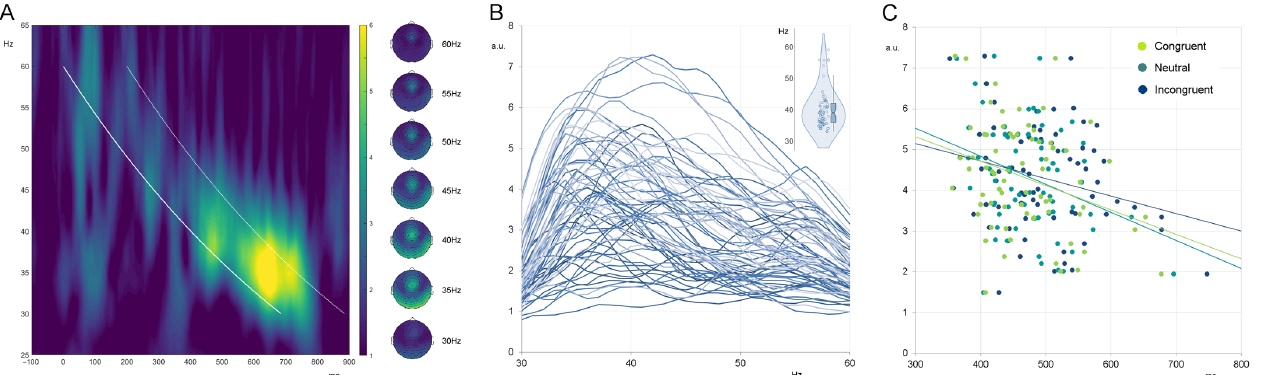
Figure 2. ( A ) The grand averaged time–frequency plot of the phase-locking index alongside the topographic activation plots at selected frequencies. ( B ) The individual phase-locking index curves and distribution of IGF. ( C ) Scatterplots of PLI values obtained at IGFs against reaction times in congruent, neutral, and incongruent conditions of the Bivalent Shape Task. a.u.—arbitrary units.